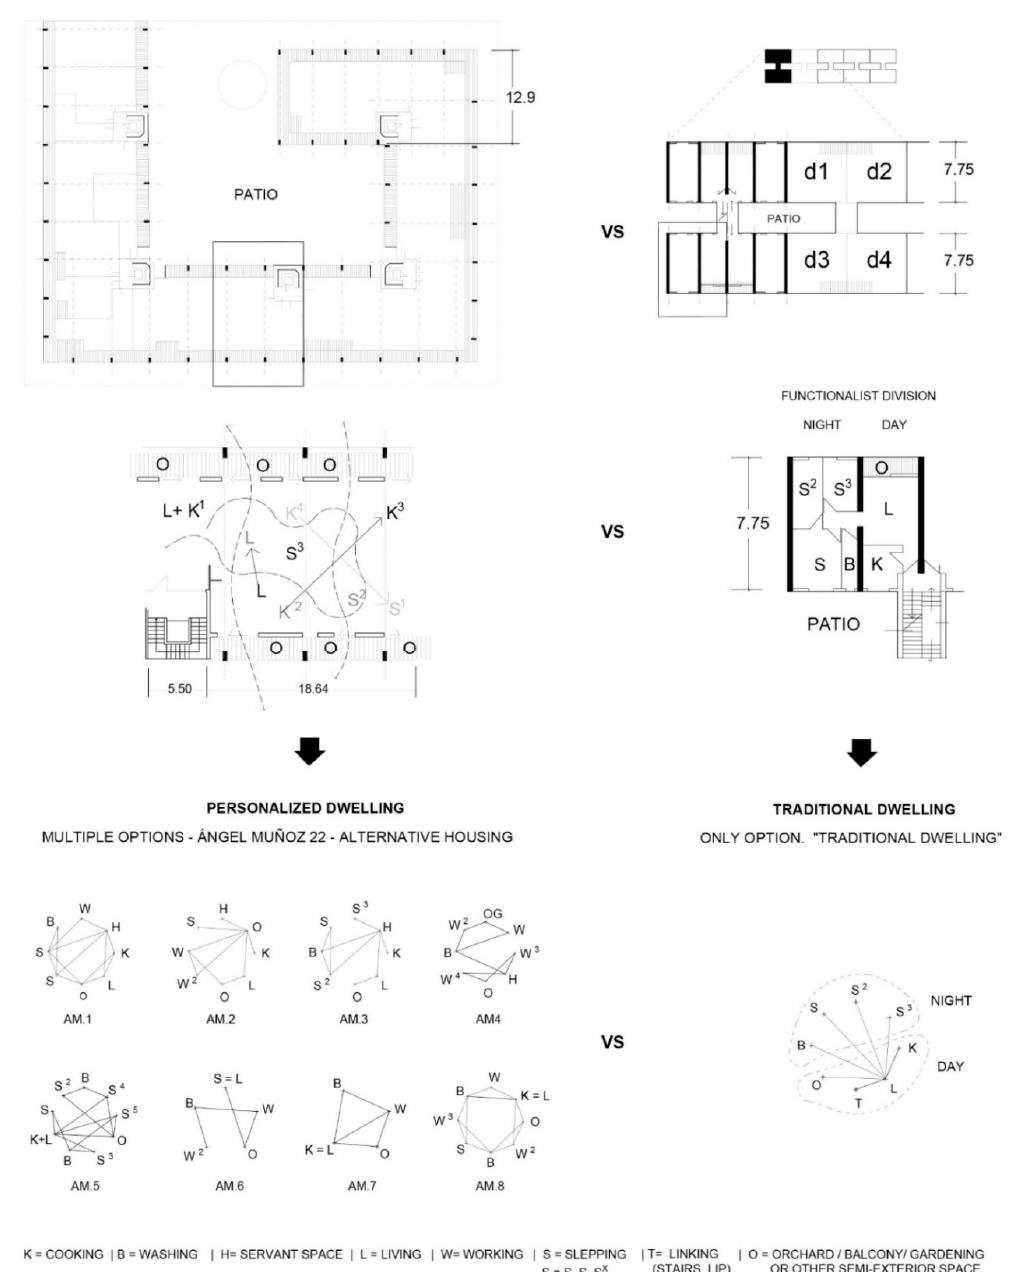
Figure 4. Critical comparison between Ángel Muñoz 22’s “customizable or adaptable housing” (left side) and the “segregated housing” (right side), both in Madrid in the 1970s. In the last row, “multiplicity of habitat solutions” can be seen through “Graphos analysis” and “space syntax” analyses of eight different dwellings. In the “rigid” case study, on the right, only a single model is provided, while in the case study of 1975, each dwelling is different. Source: Drawing by author.